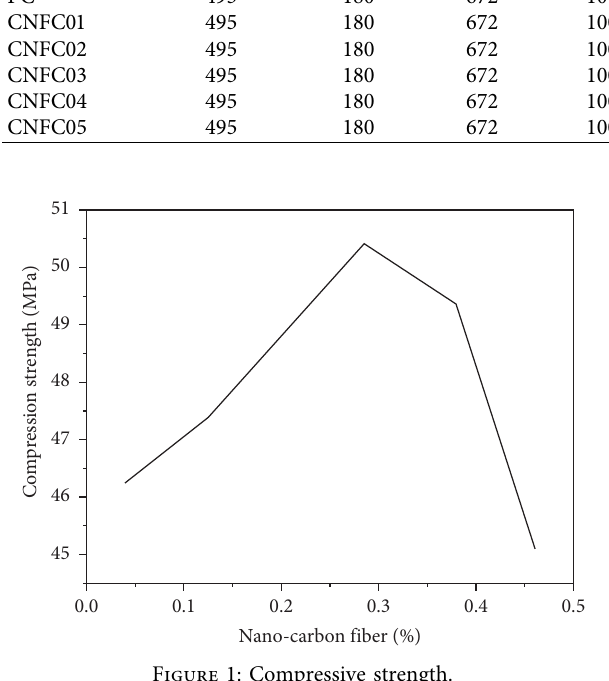
Figure 1: Compressive strength.